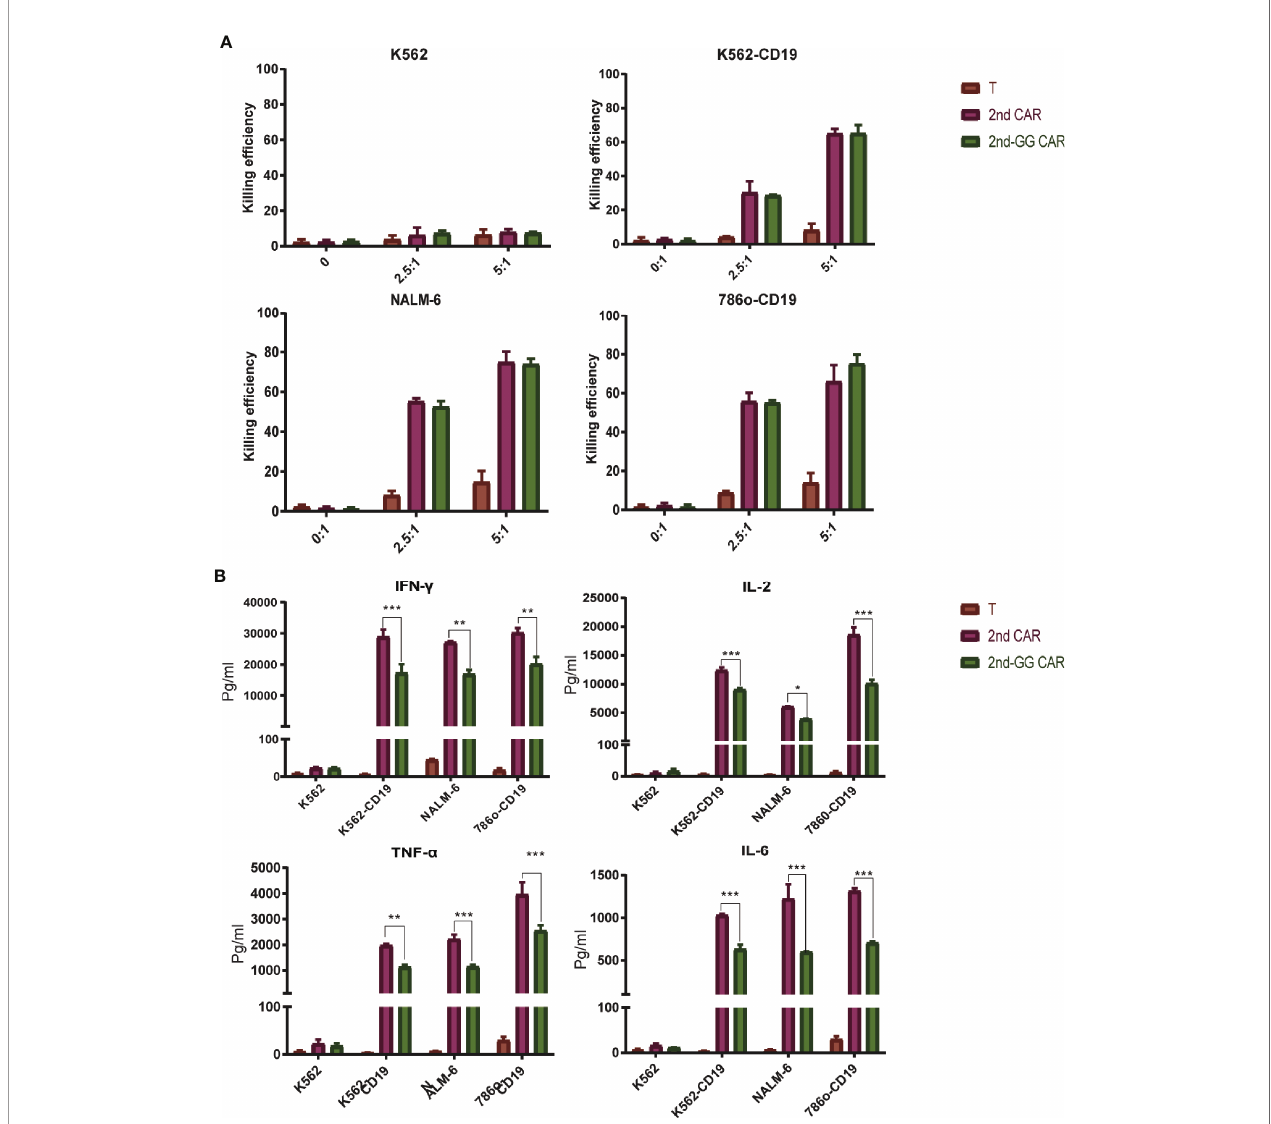
FIGURE 2 | The killing ef fi ciency and cytokine secretion of 2nd CAR-T and 2nd-GG CAR-T cells towards tumor cells. (A) Cytotoxic percentages of targeted cells by mock T, 2nd and 2nd-GG CAR-T cells after 8 – 10 h of co-culture in vitro . E: T (2.5:1 and 5:1) designate the ratios of the absolute number of CAR T cells to target cells, speci fi cally K562, NALM-6, 786o-CD19, and K562-CD19. The number of mock T cells is the same as in the 2nd CAR-T cells group. Results are representative of at least three independent experiments with T cells from different healthy donors. (B) Human IFN g , TNF- a , IL-2 and IL-6 production by mock T, 2nd and 2nd-GG CAR-T cells. Cytokine concentrations in the media were measured after 24 h of co-incubation with different target cells at E: T of 1:1. Values are mean ± SD of triplicate specimens obtained with T cells isolated from one healthy donor. *P < 0.05; **P < 0.01; ***P <